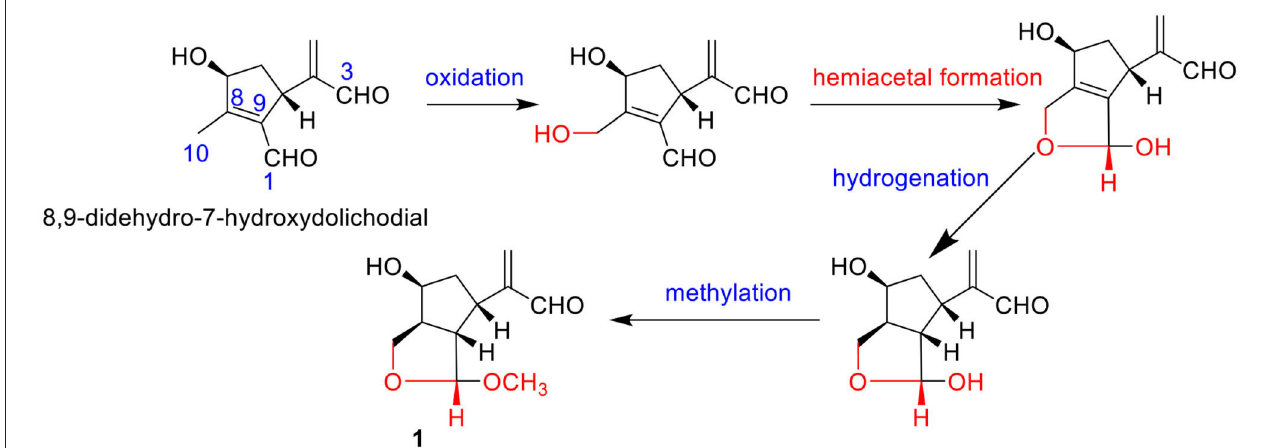
FIGURE 2 | The possible pathway for the transformation of compound 1.